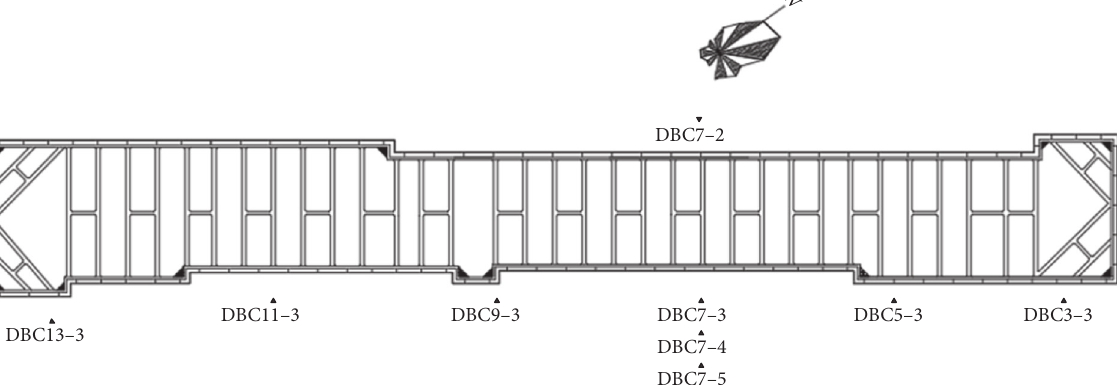
Figure 8: Layout of the surrounding ground subsidence measuring points.